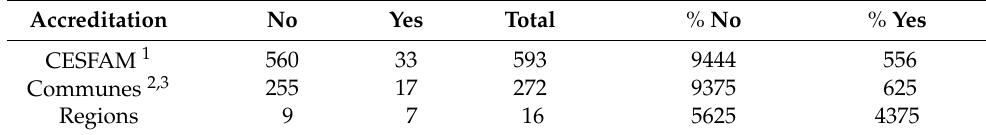
Table 1. Summary of CESFAMs accredited in Chile as of December 2019.